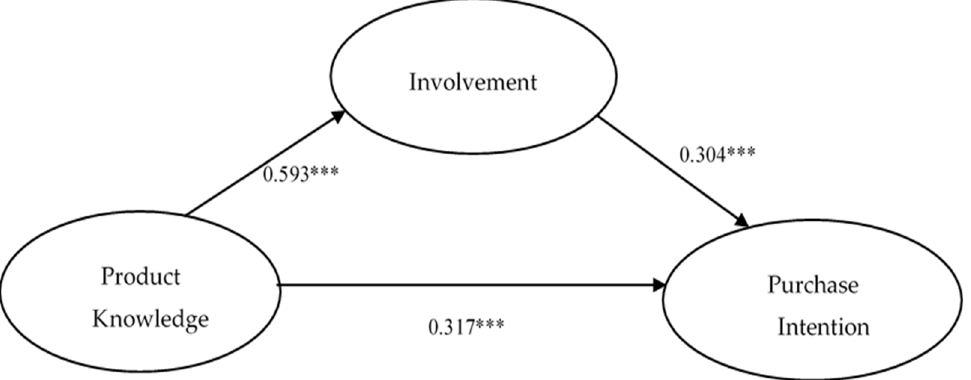
Table 3. Summary of Goodness-of-Fit Indices for the Structural Models.